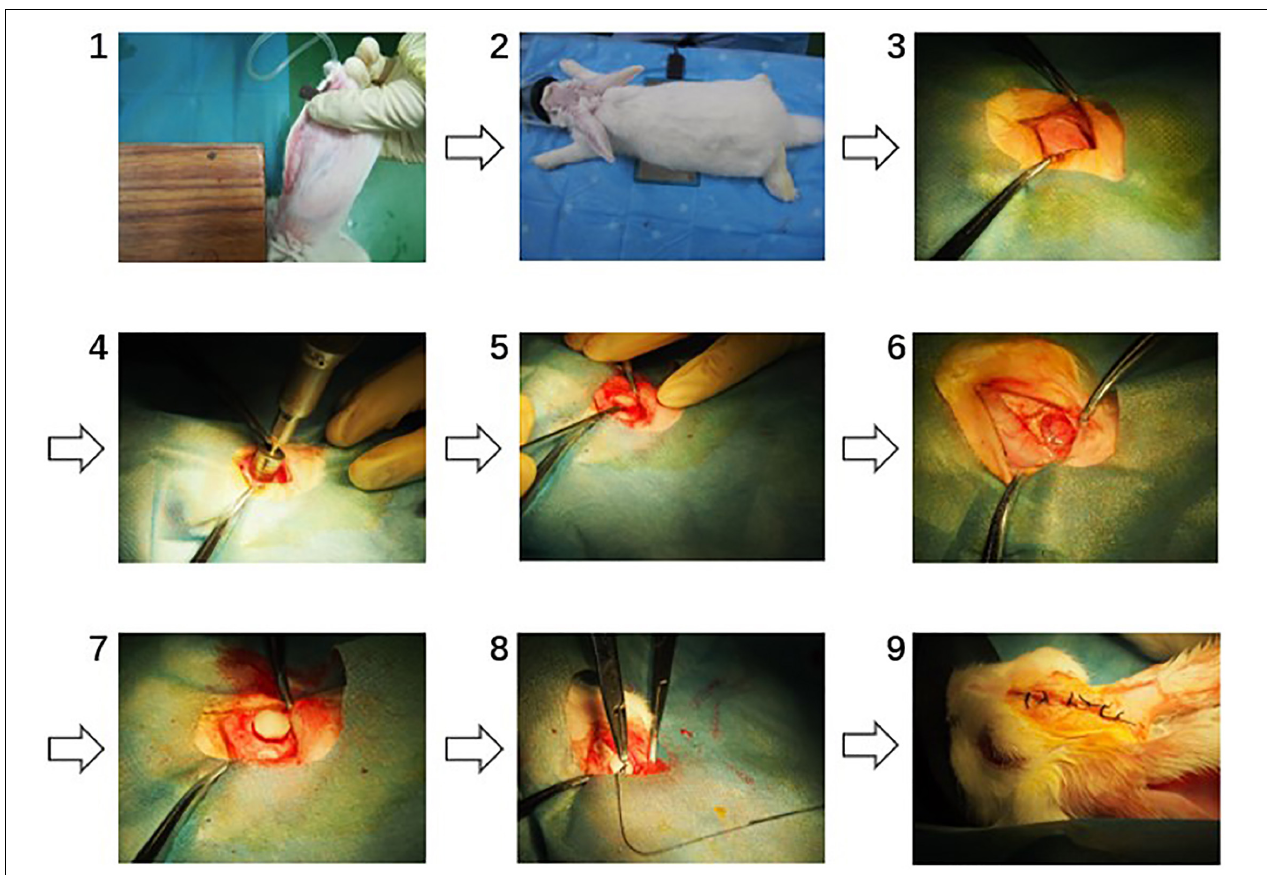
FIGURE 1 | The surgical procedures of dura mater implantation (1: anaesthetization, 2: exposure of surgical site, 3: exposure of the skull, 4: round opening on the skull, 5: establishing of dura mater defect, 6: established dura mater defect, 7: dura substitute implantation, 8: suturing, 9: